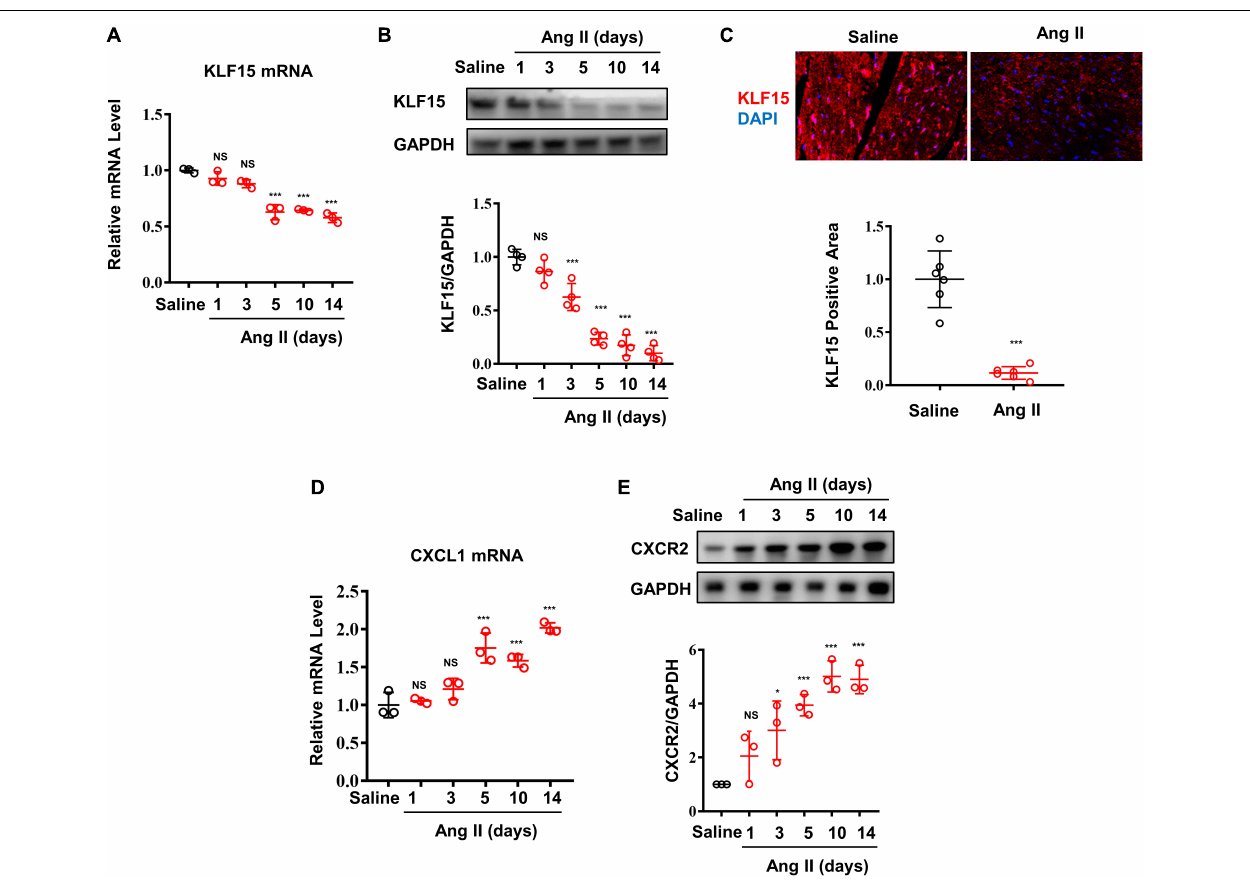
FIGURE 1 | Ang II induced decrease of KLF15 expression associating with increase of CXCL1/CXCR2 expression. Mice were infused with saline or Ang II (1,000 ng/kg/min) for the indicated time. (A) Cardiac KLF15 mRNA was detected and analyzed by qPCR. (B) KLF15 protein expression was detected and analyzed by Western Blot. (C) Representative immunofluorescence image of KLF15 in mice heart section (upper) and quantification analysis (lower). (D) CXCL1 mRNA was measured and analyzed by qPCR. (E) CXCR2 protein was detected and analyzed by Western Blot. * P < 0.05 and *** P <